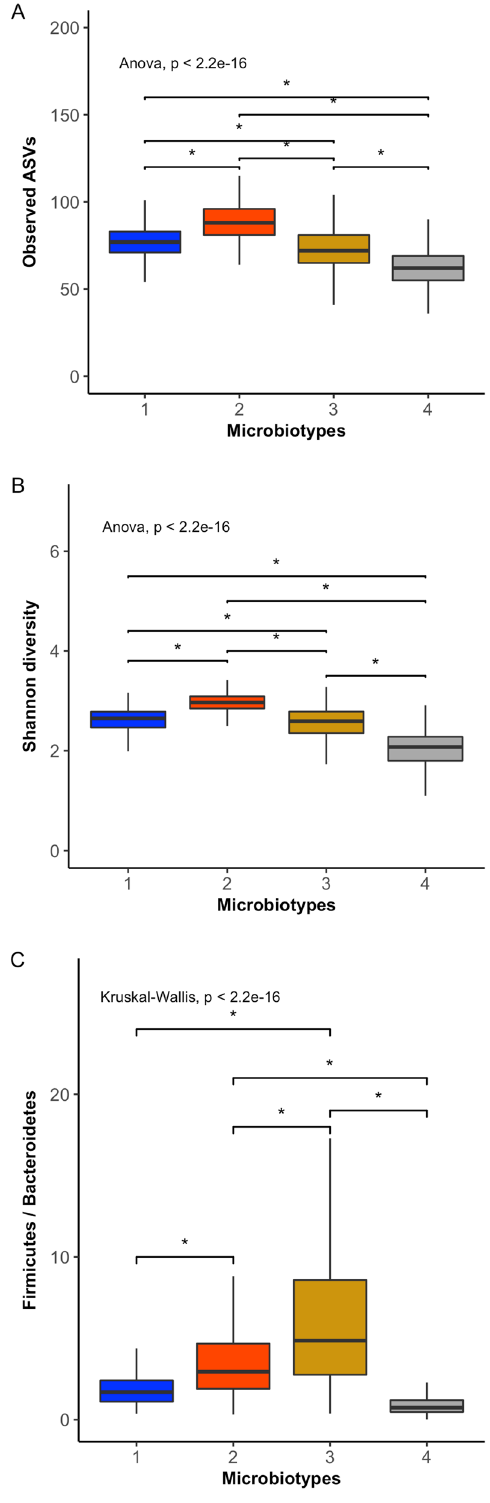
Figure 5. Ecological characteristic of the distinct microbiotypes. Box-plots show the Observed ASV diversity ( A ), Shannon diversity ( B ), Firmicutes/Bacteroidetes ratio ( C ) for each microbiotypes. The solid black lines indicate medians, and the lower and upper bounds of the box represent the 25 and 75% quartiles. Statistical differences (*) between microbiotypes were determined using ANOVA or Kruskal Wallis test supported by Tukey or Dunn test respectively (p <